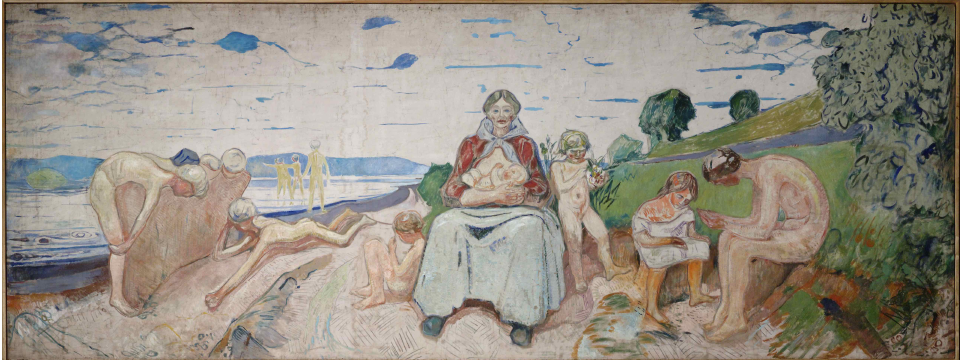
Figure 3: Alma Mater (1911/1925-27) ©